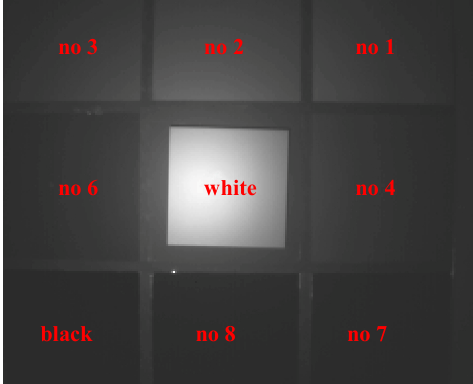
Figure 2. Grey plates used for the